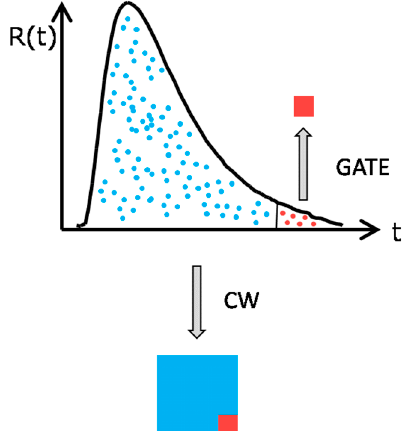
Figure 1. Using time-gating it is possible to extract few late photons (red) carrying information from deeper regions. Conversely, a classical continuous wave (CW) measurement (blue and red) mix all the photons, diluting depth sensitivity.